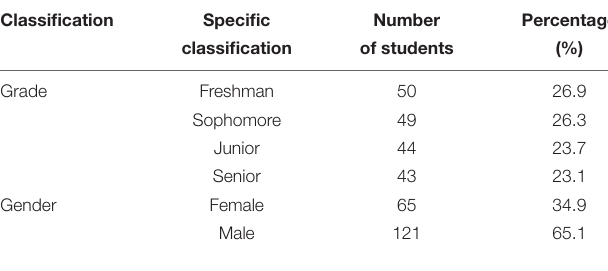
TABLE 2 | The specific distribution of the investigated college students.